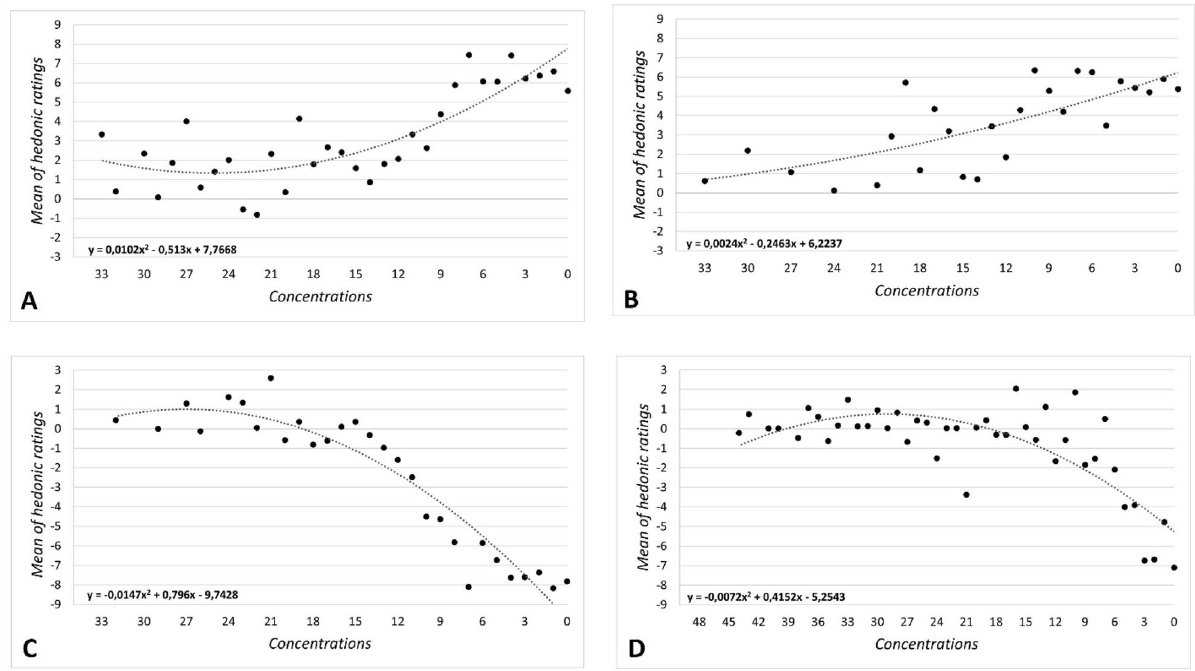
Figure 4. Odor hedonic ratings above odor detection thresholds: mean hedonic ratings in relation to concentrations. ( A ) apple, ( B ) jasmine, ( C ) durian, ( D ) trimethylamine. The line grey color responds to the polynomial regression. Equations of polynomial regressions is given on each graph.